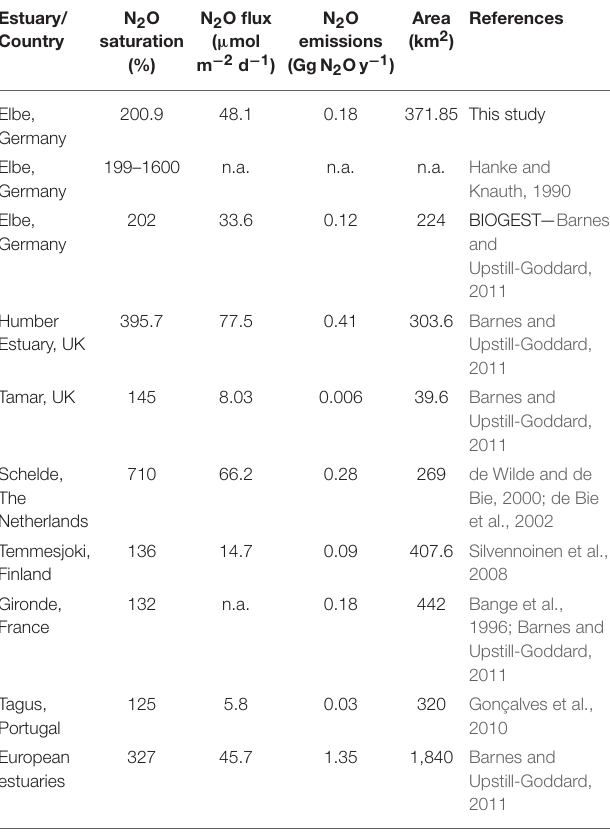
TABLE 1 | Comparison of N 2 O saturations, fluxes and emissions from European estuaries. Estuary/